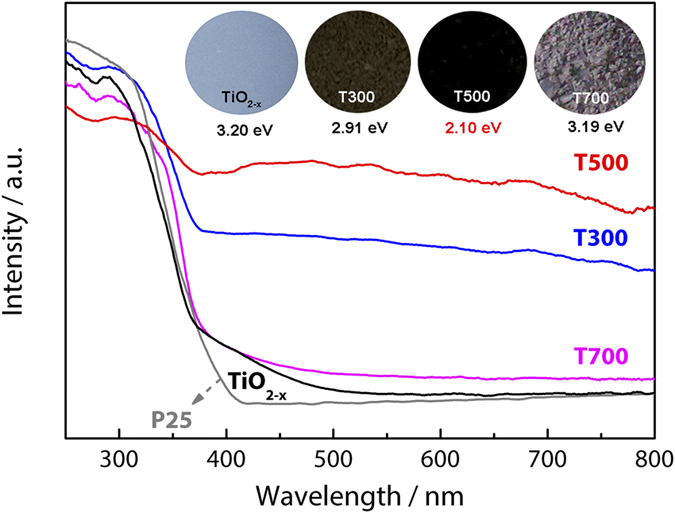
UV-vis diffuse reflectance spectra of the as-prepared brookite TiO2−x, T300, T500 and T700.